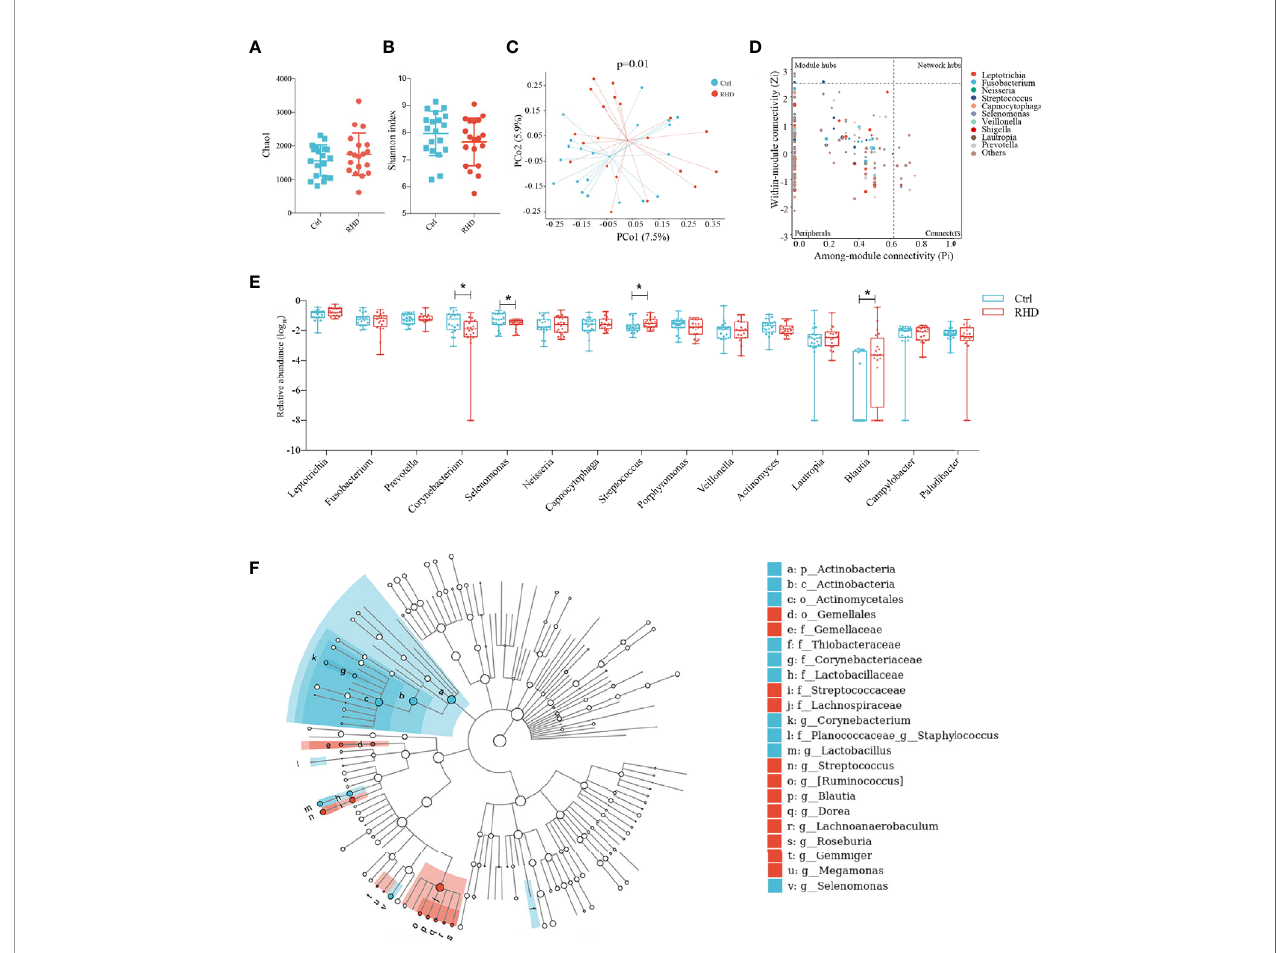
FIGURE 2 | Alterations of subgingival plaque microbiota in patients with rheumatic heart disease. Microbiota of subgingival plaques (SP) from patients with rheumatic heart disease (RHD) and control subjects (Ctrl) were analyzed using 16S rRNA gene sequencing. (A) Richness of SP microbiota assessed by Chao1. (B) a -diversity of SP microbiota assessed by Shannon index. (C) b -diversity analyzed by principal coordinate analysis (PCoA) based on Bray – Curtis distance of SP microbiota at genus level. (D) Determination of module-based topological roles (peripherals, connectors, module hubs, or network hubs) of SP microbiota in RHD patients using ZP-plot at genus level. The size of dots represents abundance of each genus. (E) Relative abundances of the fi fteen most abundant genera in SP microbiota. (F) Taxonomic cladogram of SP microbiota based on LEfSe. Red color indicates increase and blue indicates decrease of taxa in RHD compared to Ctrl. LDA = 3. Mann – Whitney test was used. n = 20: 20. *P <